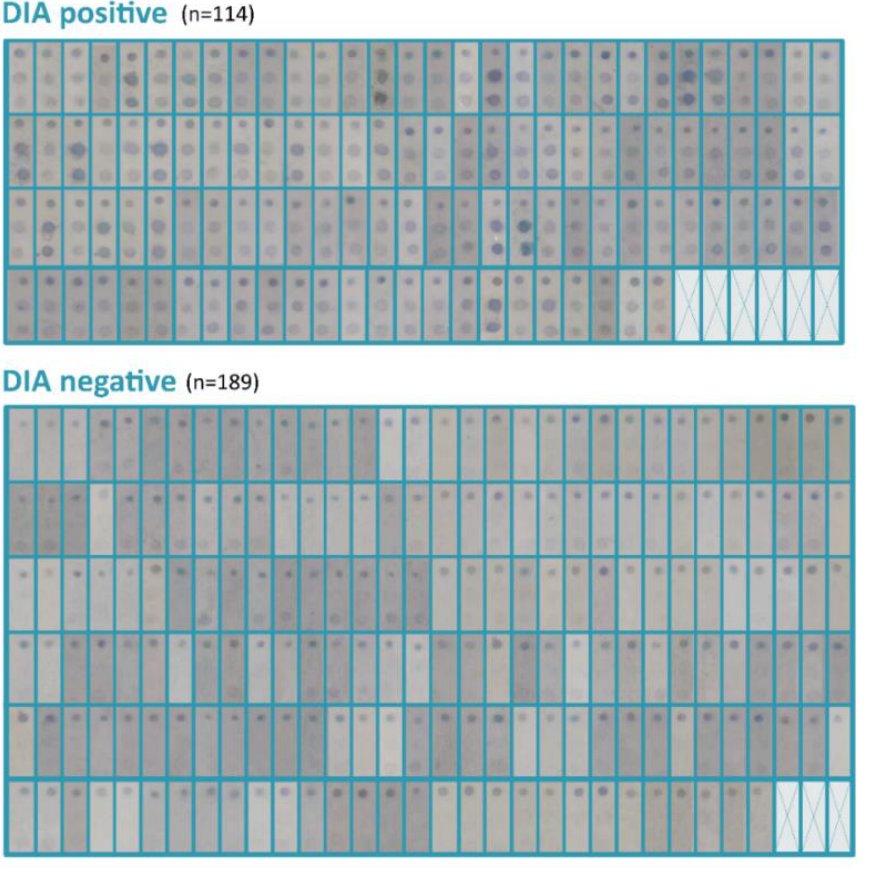
Table 1. Test performance. Contingency tables comparing the results of the DIA rapid test for anti-